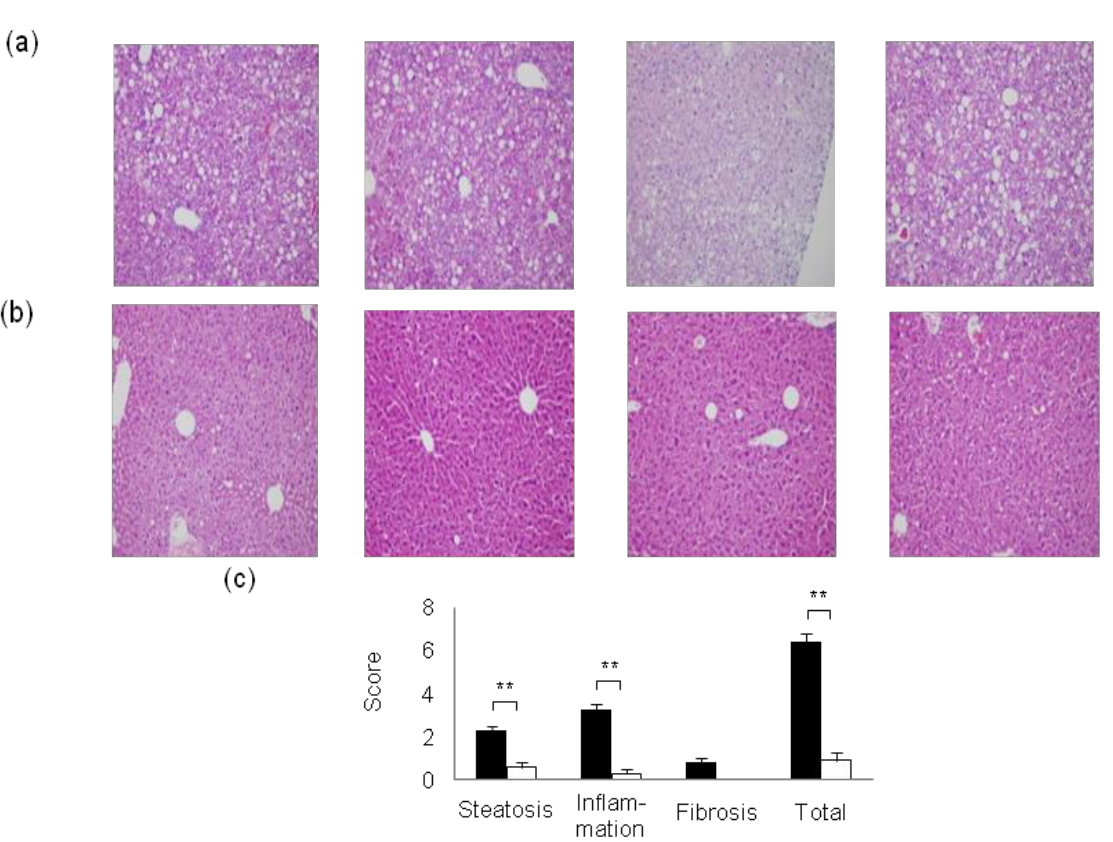
Figure 3. Histopathological features of livers from WT and Irs1 −/− mice fed the HF diet for 60 weeks, as assessed in H&E-stained sections (( a ): WT; ( b ): Irs1 −/− ), and pathological scores for WT and Irs1 −/− mice fed the HF diet for 60 weeks; ( c ) (WT: filled bar, Irs1 −/− : open bar). Values are the means ± S.E. ** p < 0.01